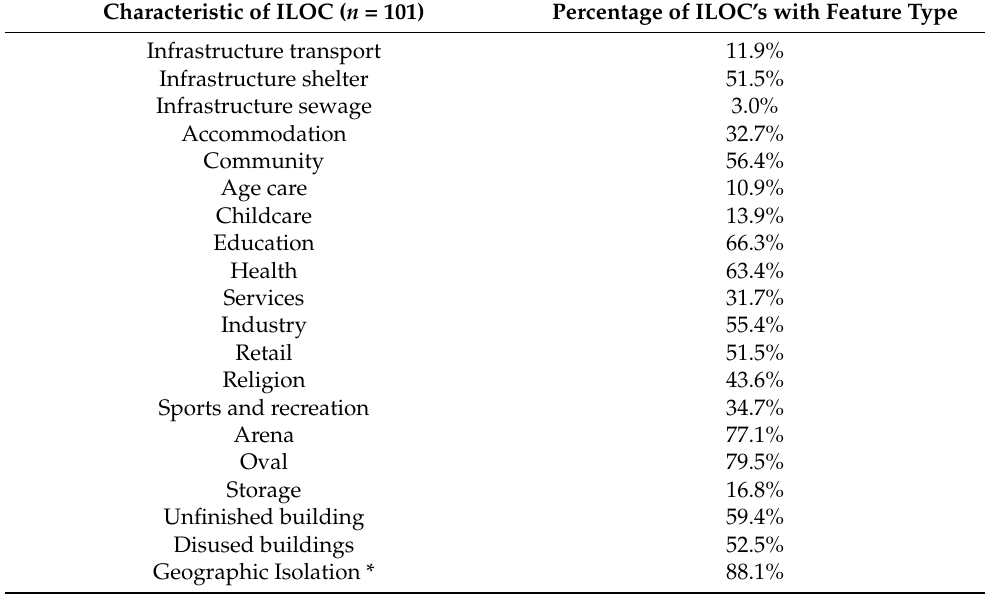
Table 1. ILOC-level descriptive